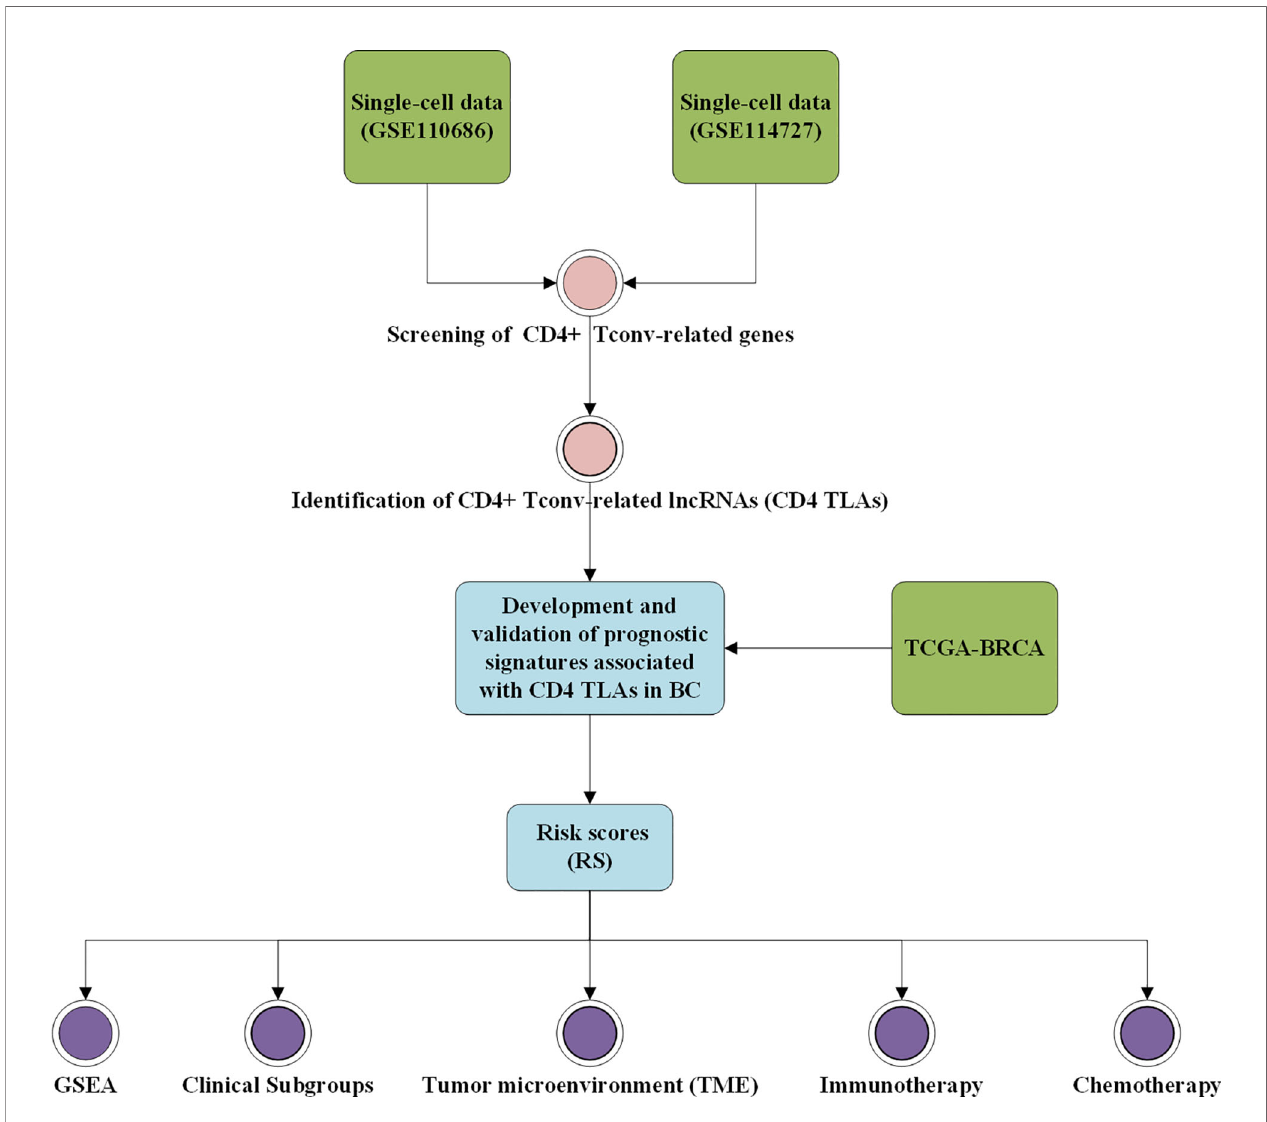
FIGURE 1 | Work fl ow diagram. The speci fi c work fl ow graph of data